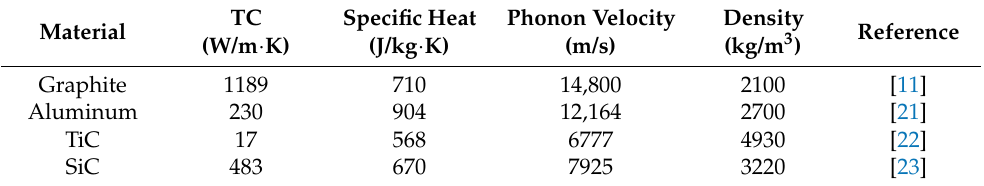
Table 2. Parameters of materials for the acoustic mismatch model (AMM)